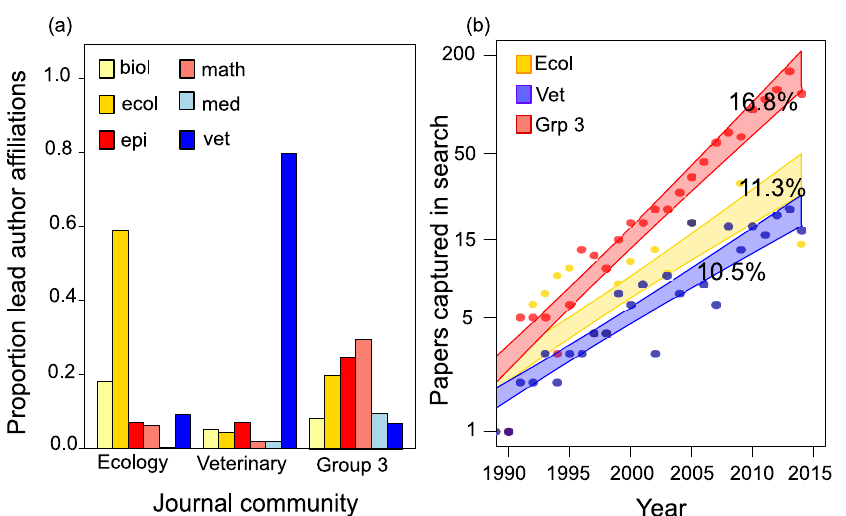
Fig 1. Participant diversity and publication growth. (A) Proportion of lead author affiliation disciplines across all 1,551 papers published in journals in the three major journal communities. “ Math ” here encompasses “ math ” and “ stat ” affiliations; “ ecol ” encompasses “ eco, ” “ evo, ” and “ biol ” affiliations; “ vet ” captures “ vet, ” “ animal health, ” and “ animal science; ” “ Med ” captures “ med ” and pharmacy affiliations. (B) Number of papers captured by our search through time. Blue = veterinary community; gold = ecology community; red = group 3. Numbers are the annual percent growth rate within each community. Data to generate this figure are contained in S1